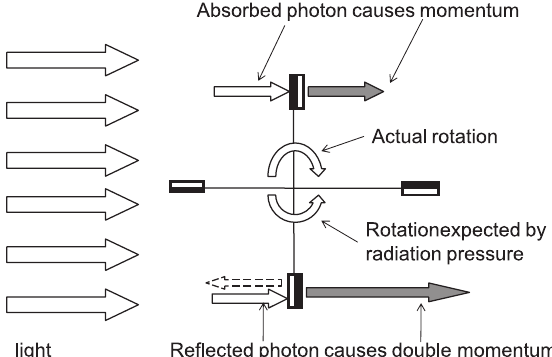
Fig. 2 Schematics of the radiometer